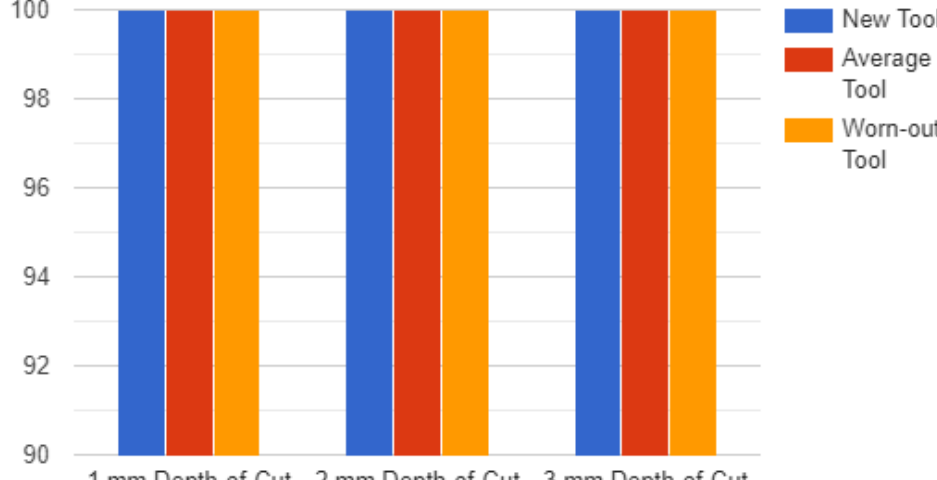
Figure 19. Accuracy Chart for Hardwood.